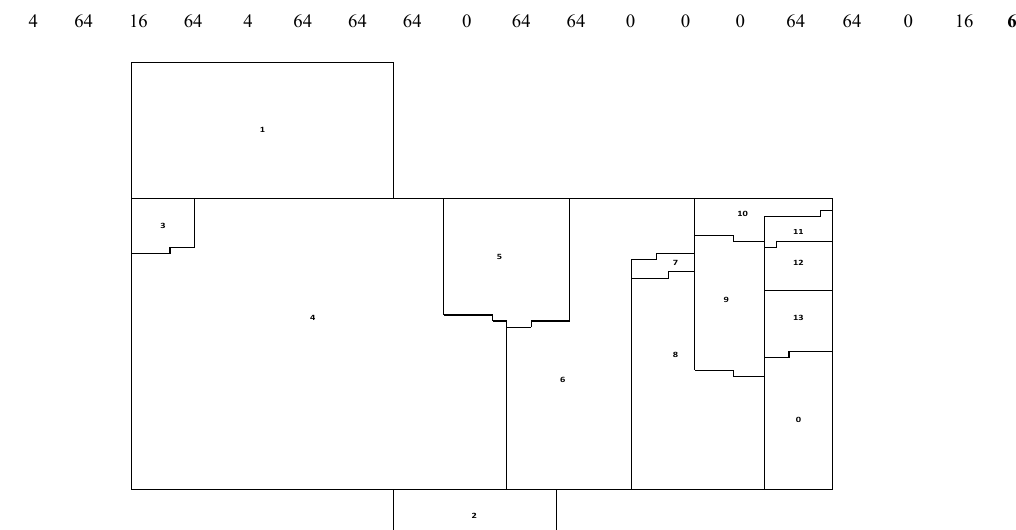
Fig. 8. Layout generated by